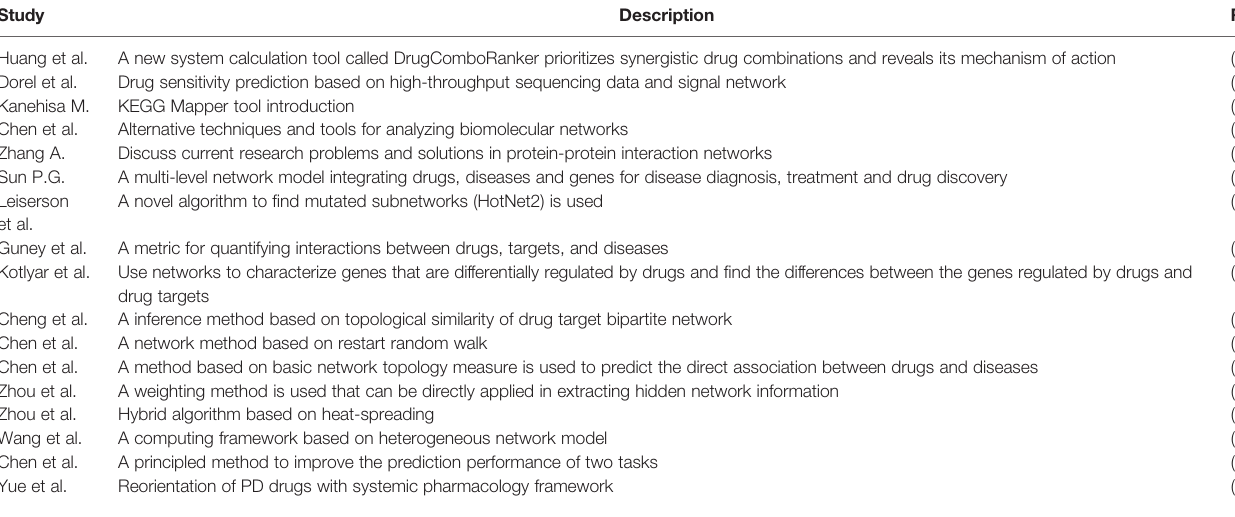
TABLE 3 | Network-based